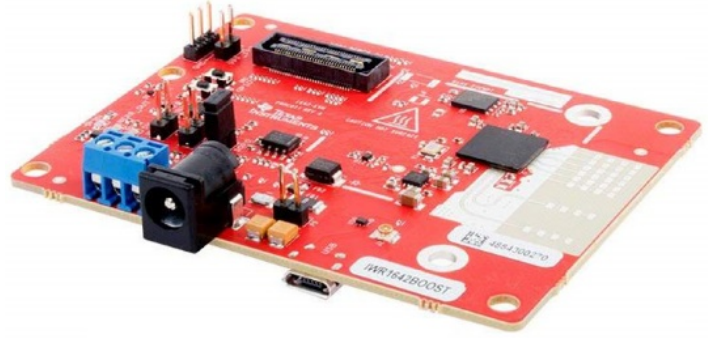
Figure 7. IWR1642.